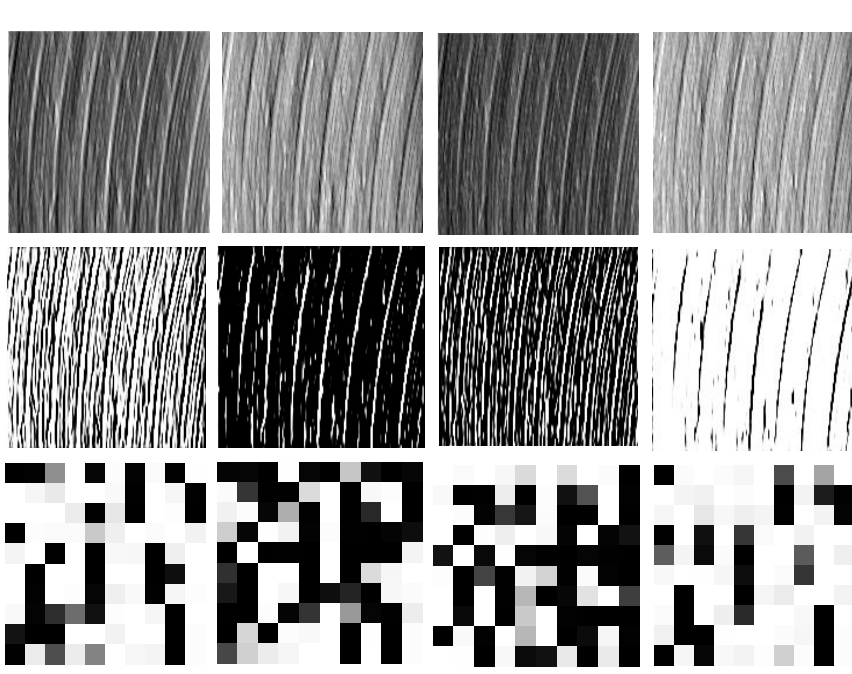
Figure 18. Filter characteristic.